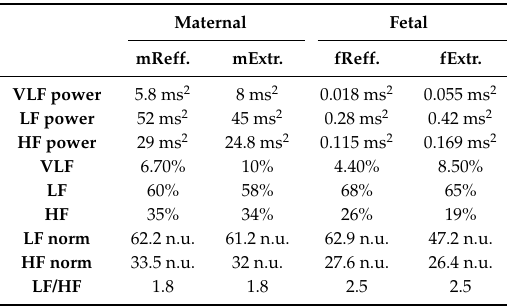
Table 8. Autoregressive (AR) spectrum; frequency domain statistics.